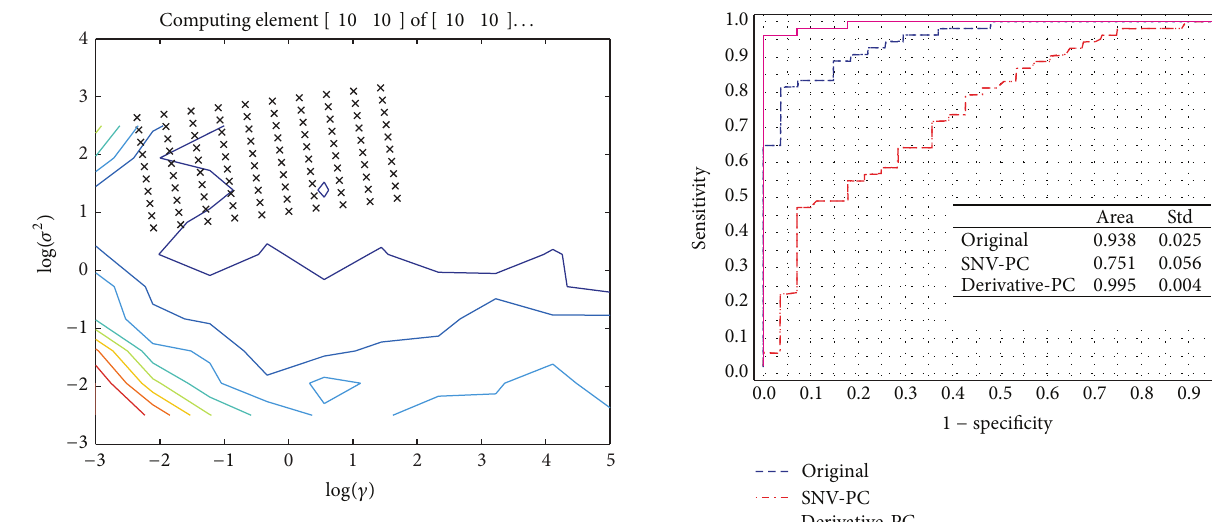
Figure 3: Contour plot of the parameter optimization of the classification model of least-squares support vector machine.